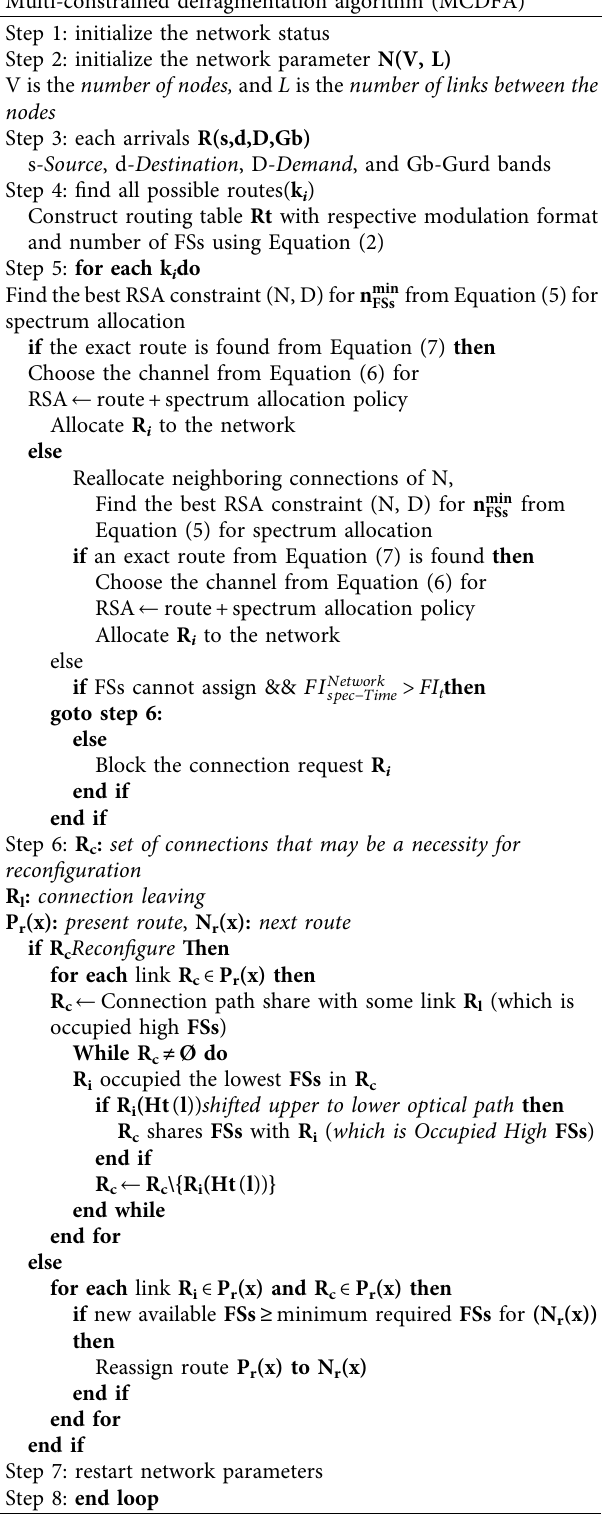
Table 2: Multi-constrained defragmentation algorithm (MCDFA). Multi-constrained defragmentation algorithm